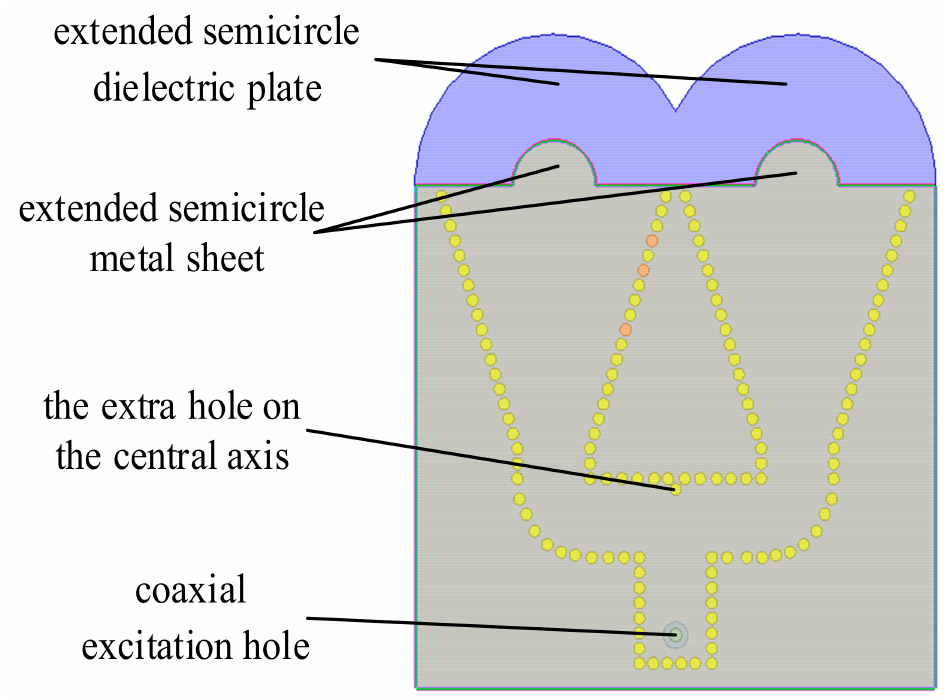
Figure 7. Schematic diagram of the improved antenna